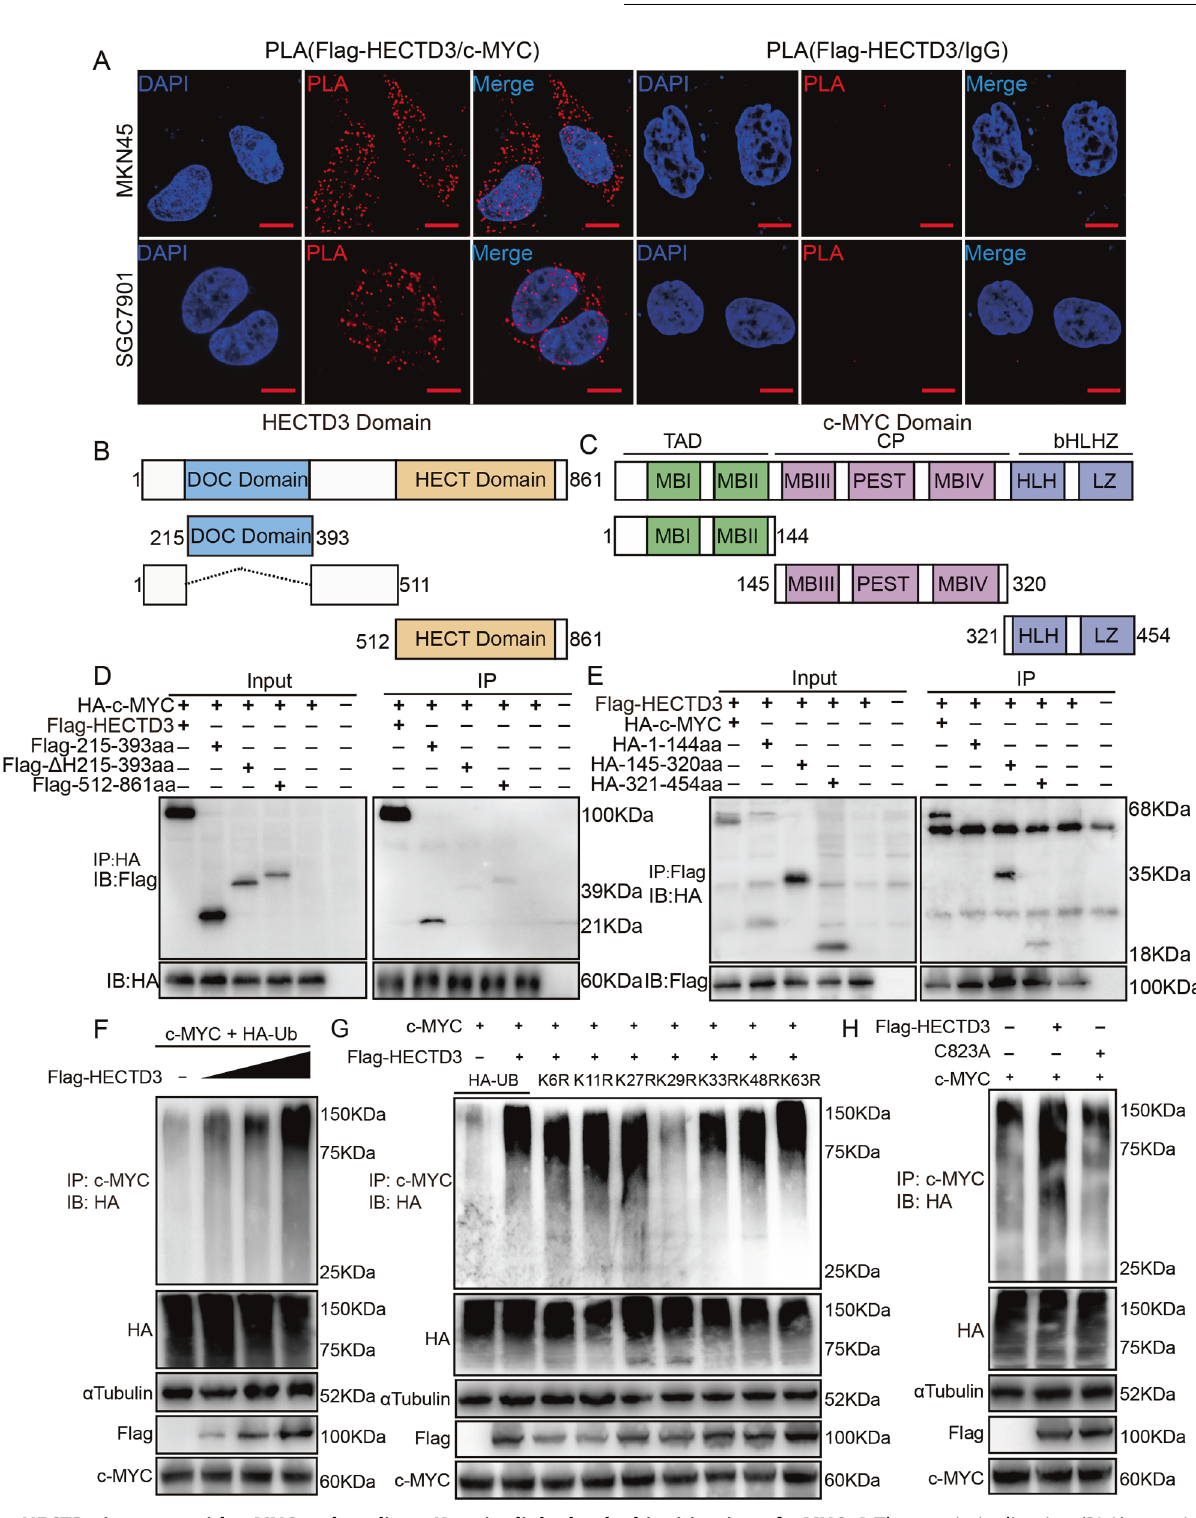
Cell Death Discovery (2022)